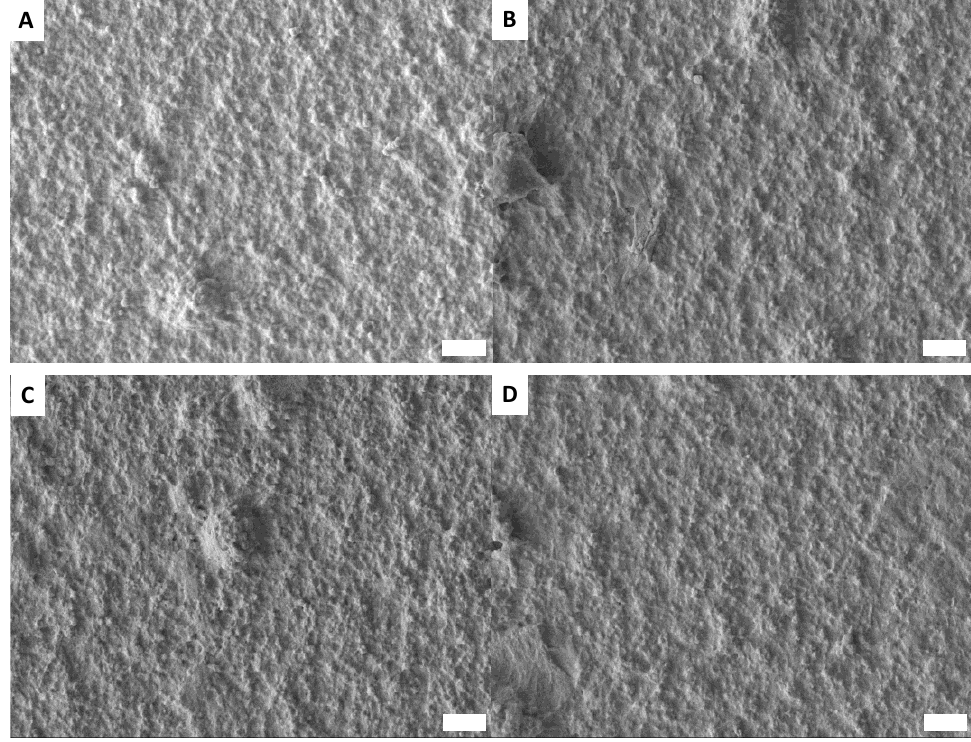
Figure 8. Morphologies observed for surfaces developed using post strategy (scale bar = 1 μm). ( A ) PEDOT-Thym-N 3 ; ( B ) PEDOT-Thym-F 4 ; ( C ) PEDOT-Thym-F 6 ; ( D ) PEDOT-Thym-F 8 .